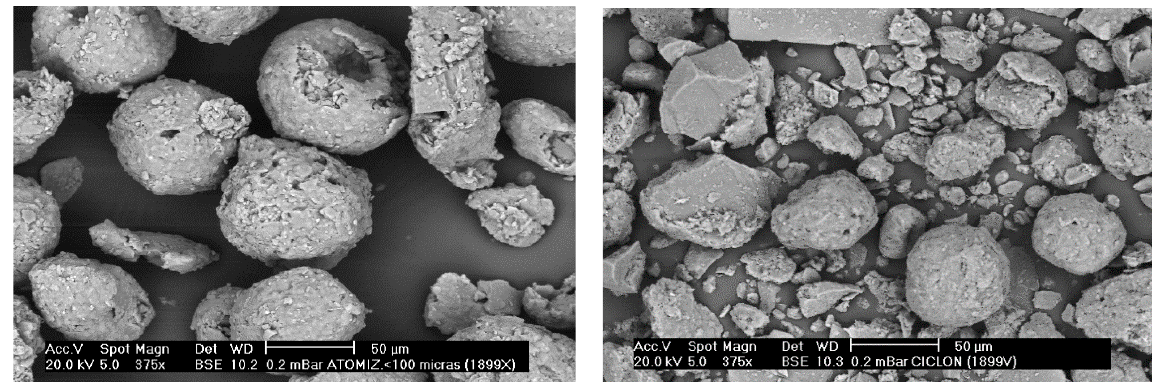
Figure 8. SEM photograph of the PM emitted by the cyclones after spray-drying.